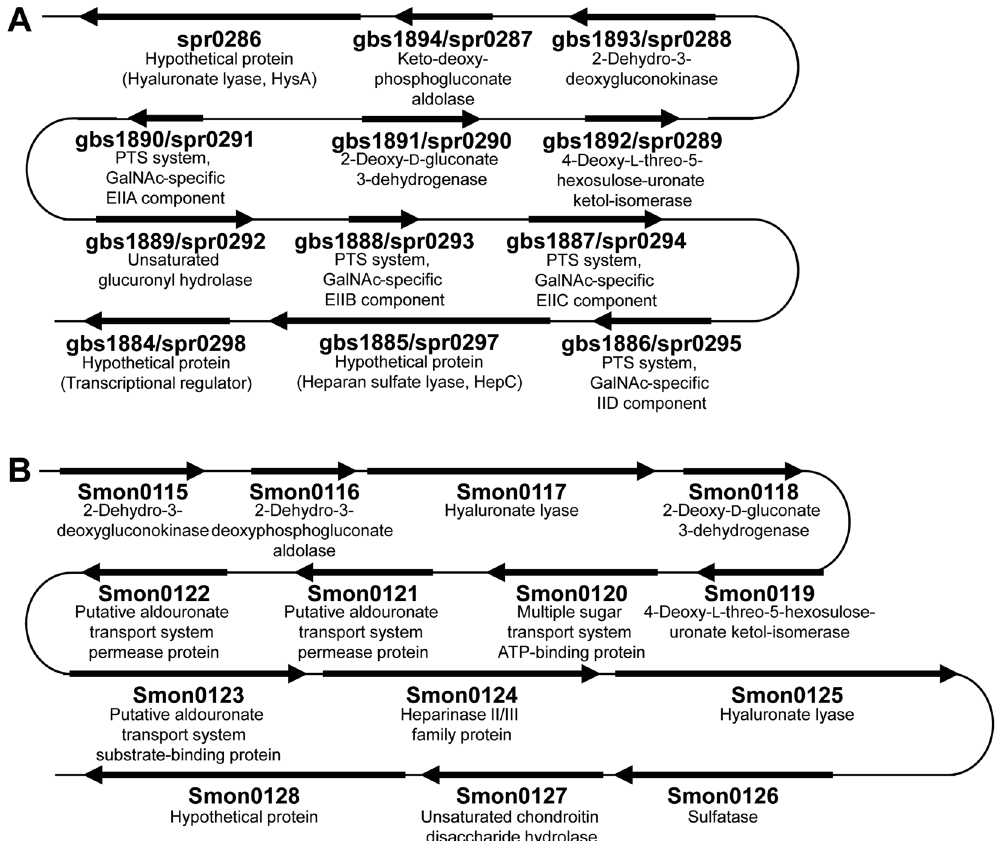
Figure 2. Bacterial GAG genetic clusters. ( A ) Genetic cluster of Streptococcus agalactiae / Streptococcus pneumoniae . ( B ) Genetic cluster of Streptobacillus moniliformis . Genes for GAG depolymerization, degradation, and metabolism, except for import, are well conserved between the two bacterial clusters. Genetic clusters of Streptococcus and Streptobacillus encode PTS and the solute-binding protein-dependent ABC transporter, respectively, as an